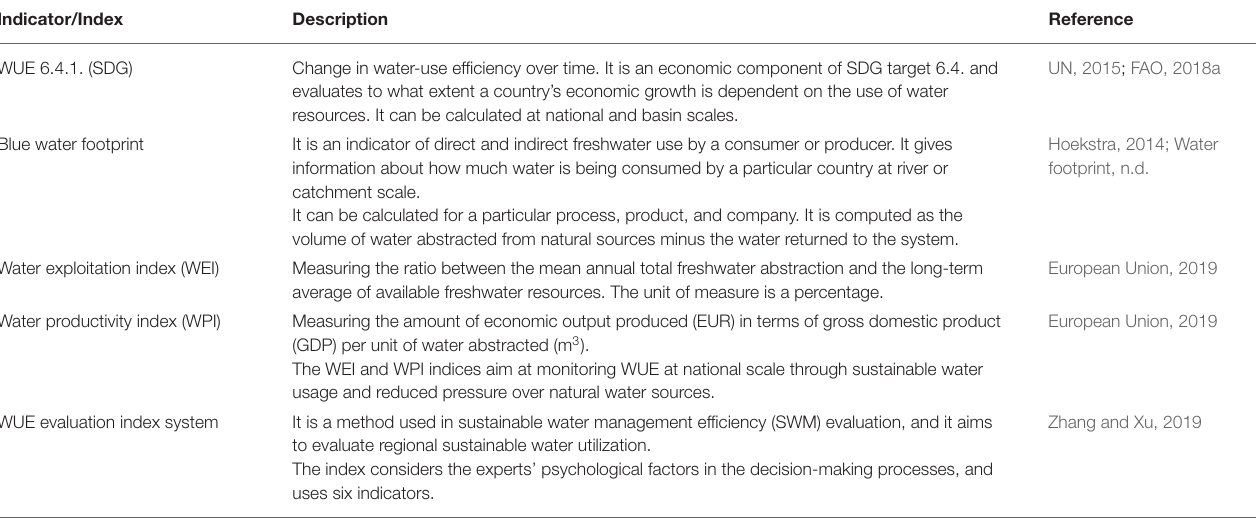
TABLE 3 | Indicators related to